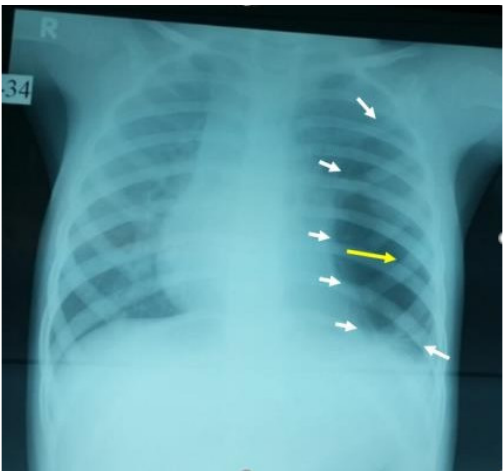
Figure 2. This AP film X-ray shows a large cystic cavity with a marked attenuated vascular marking on the left middle and lower zone, with a clear compression on the heart and ipsilateral hemidiaphragm, raising the possibility of congenital cavity lung lesion, especially CPAM-1 (the white arrows show the borders of the cyst, while the yellow arrow points to the center of the cavitation).